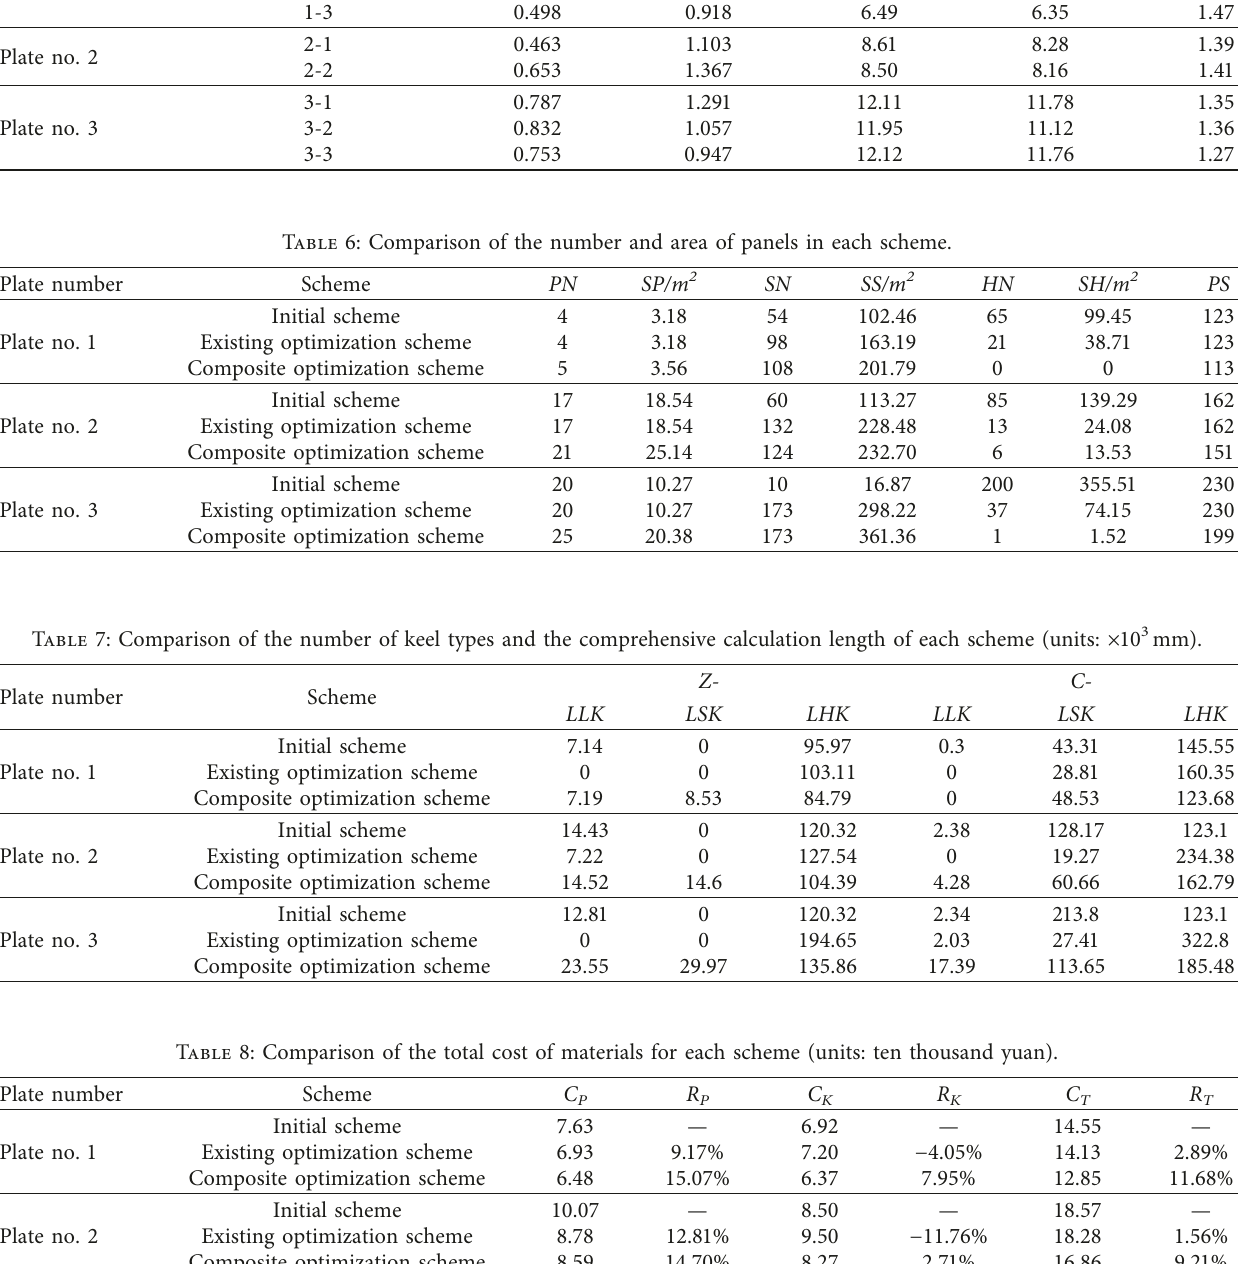
Table 5: Scheme set output impact factor prediction scheme.